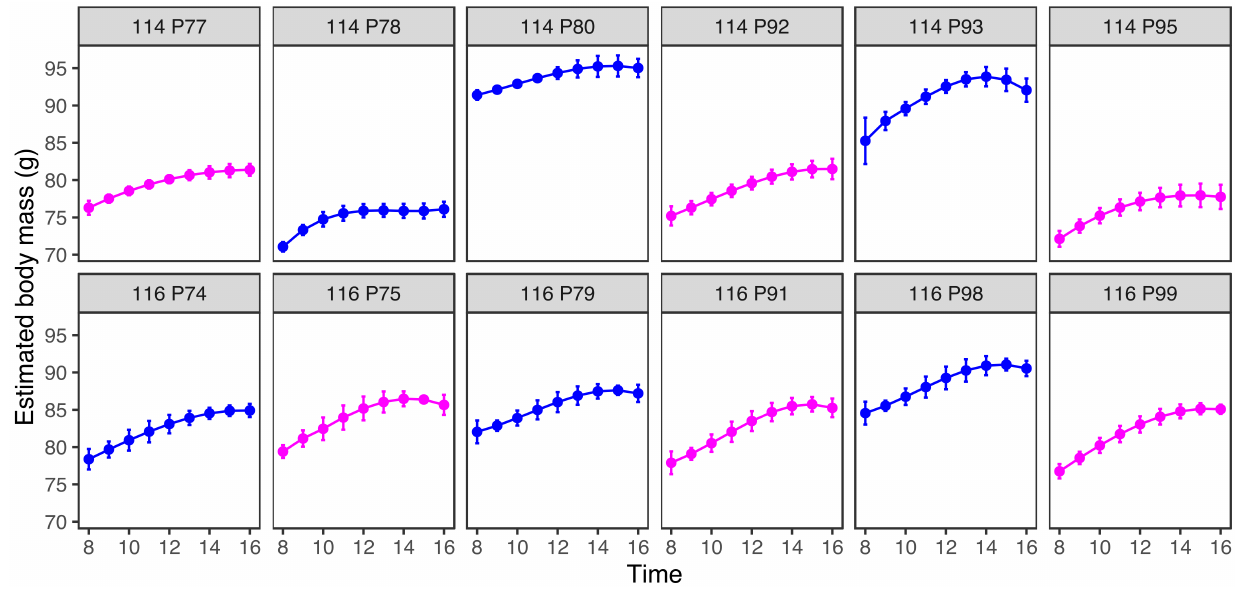
Figure 7. Body mass increased non-linearly over the course of the day, slowing or peaking toward dusk. Panels show the mean predicted mass ( ± 95% CI) by time of day for each of the 12 birds. Each row of panels corresponds to one experimental aviary. Data from male birds are shown in blue and females in pink.